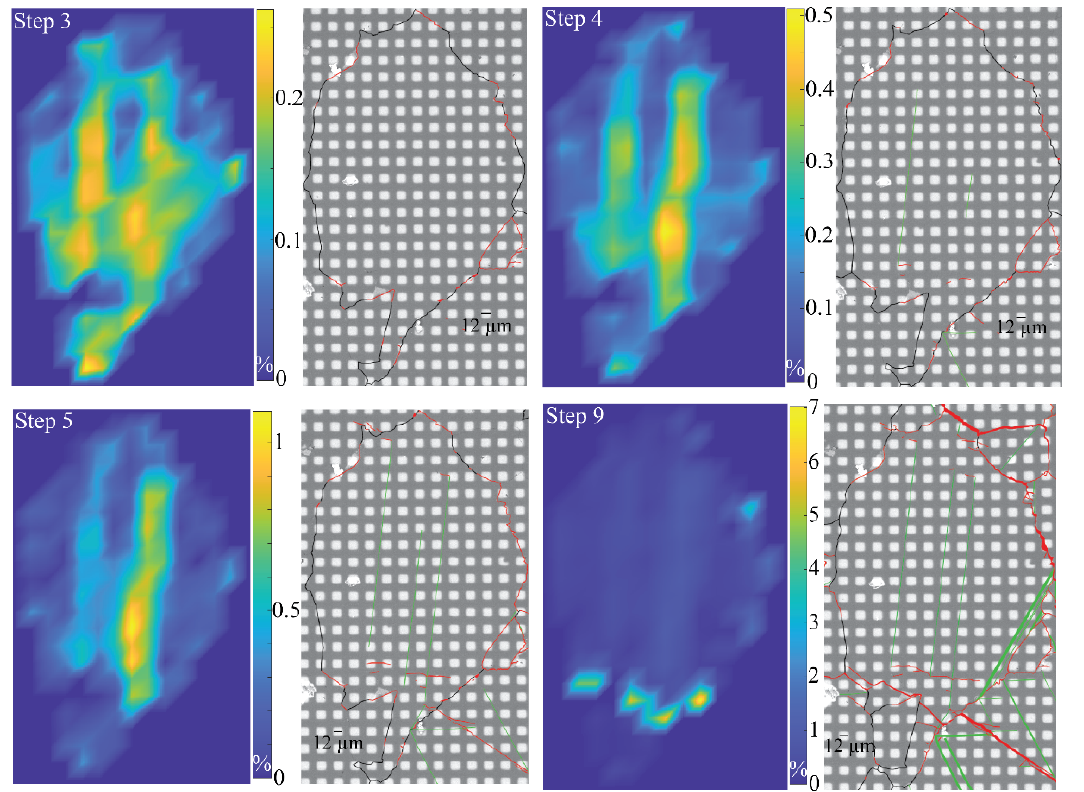
Figure 26. Equivalent Von Mises deformation map of crystal 21 at different steps of sample defor- mation. The black lines represent the grain boundaries. The green lines show the twinned planes. The red lines show the fracture zones.